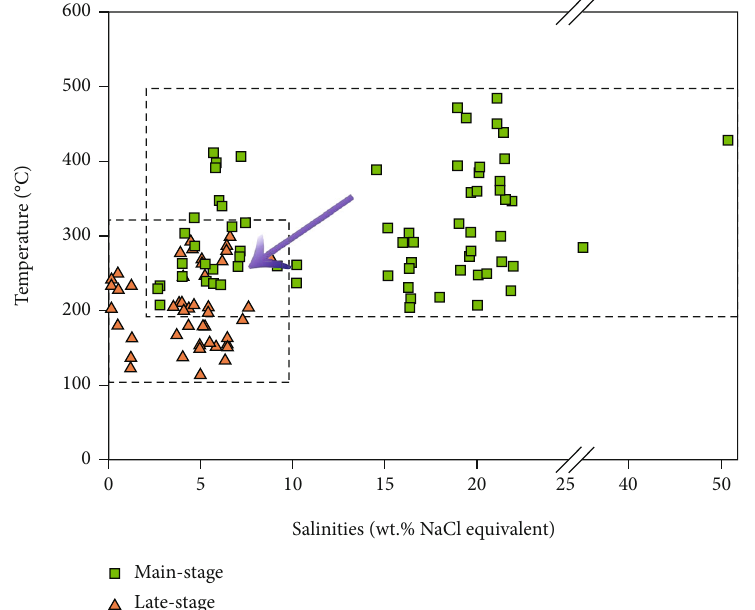
Figure 15: Homogenization temperature versus salinity plot of fl uid inclusions showing fl uid evolution in the Xinmin